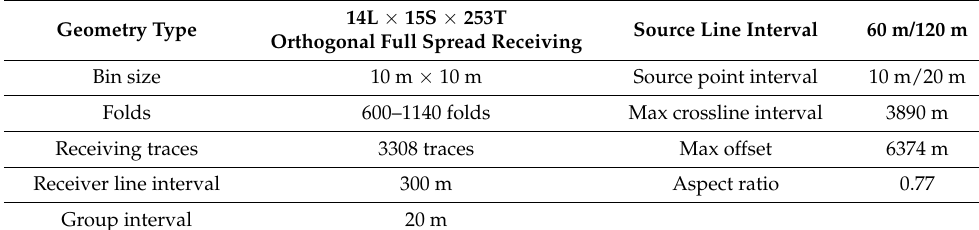
Table 2. The 3D Seismic Geometry in Well GH1 Area, Gonghe Basin.